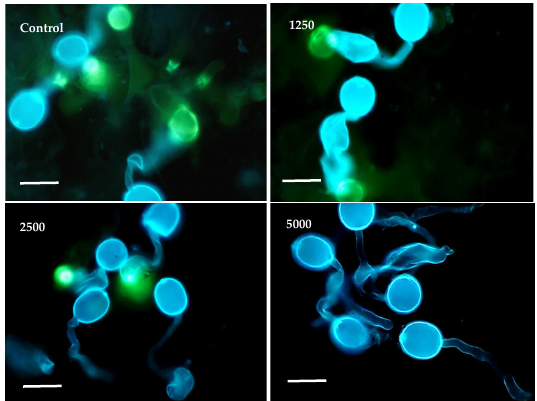
Figure 4. Fluorescence micrographs showing the effect of pure TTO (1250, 2500, and 5000 µg/mL a.i.) on germination and penetration of B. lactucae in lettuce leaves. Conidia and germ tubes fluoresce blue; infection structures inside the leaf fluoresce yellow. Bar = 20 µm. Photos were taken at 2 d after inoculation.